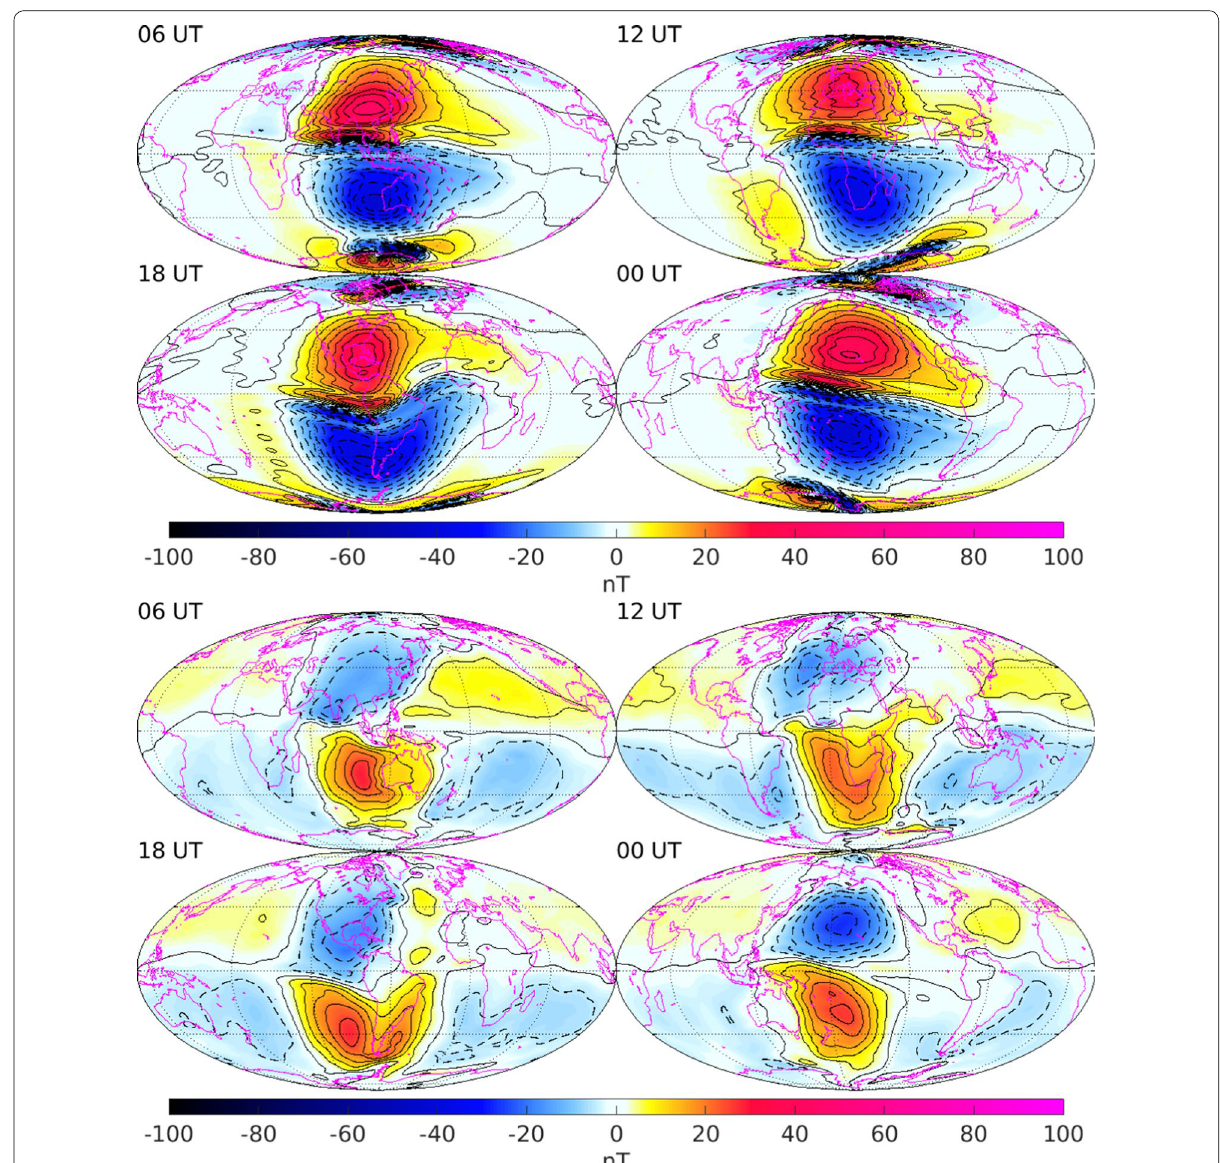
6,371.2 km during vernal equinox centered on noon = 100.0 10 − 22 W / m 2 / Hz was used for = ×